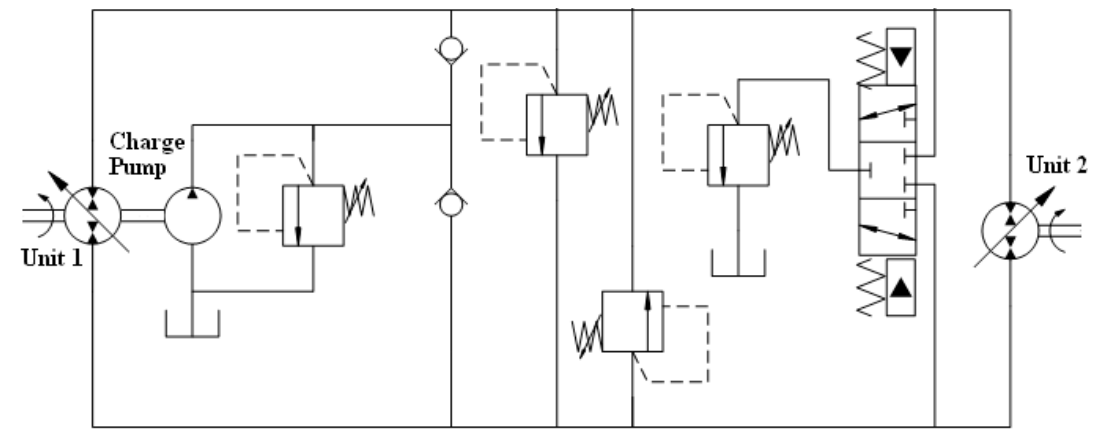
Figure 2. Hydraulic circuit of the wheel loader powertrain.